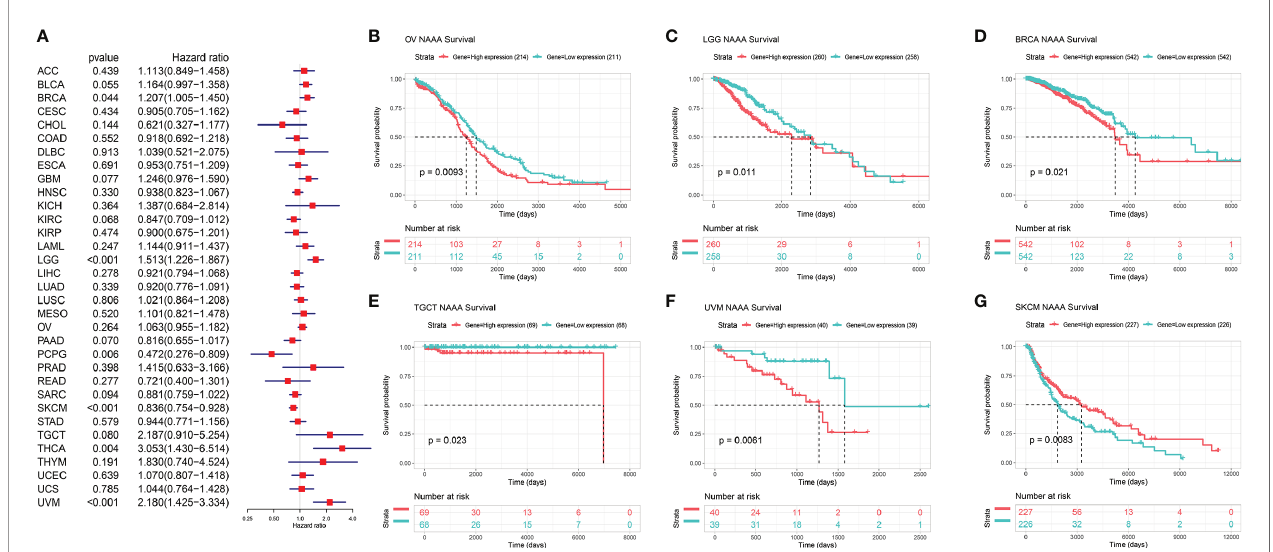
FIGURE 3 | Relationship of NAAA expression with patient Overall Survival (OS). (A) Forest map shows the univariate Cox regression analysis results for NAAA in TCGA pan-cancer samples. (B – G) Kaplan – Meier OS curves of NAAA expression in the six most signi fi cantly associated